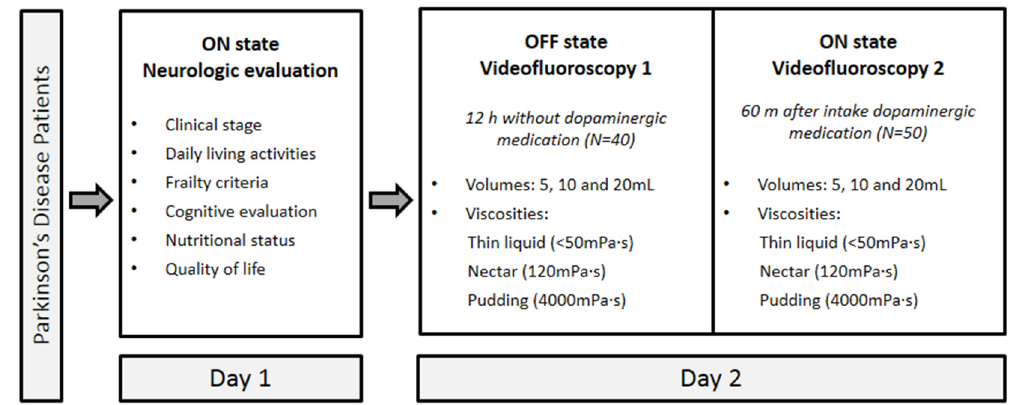
Figure 1. Two-day study design: day 1, clinical and neurological evaluation in ON; day 2, VFS1 in OFF and VFS2 in ON.